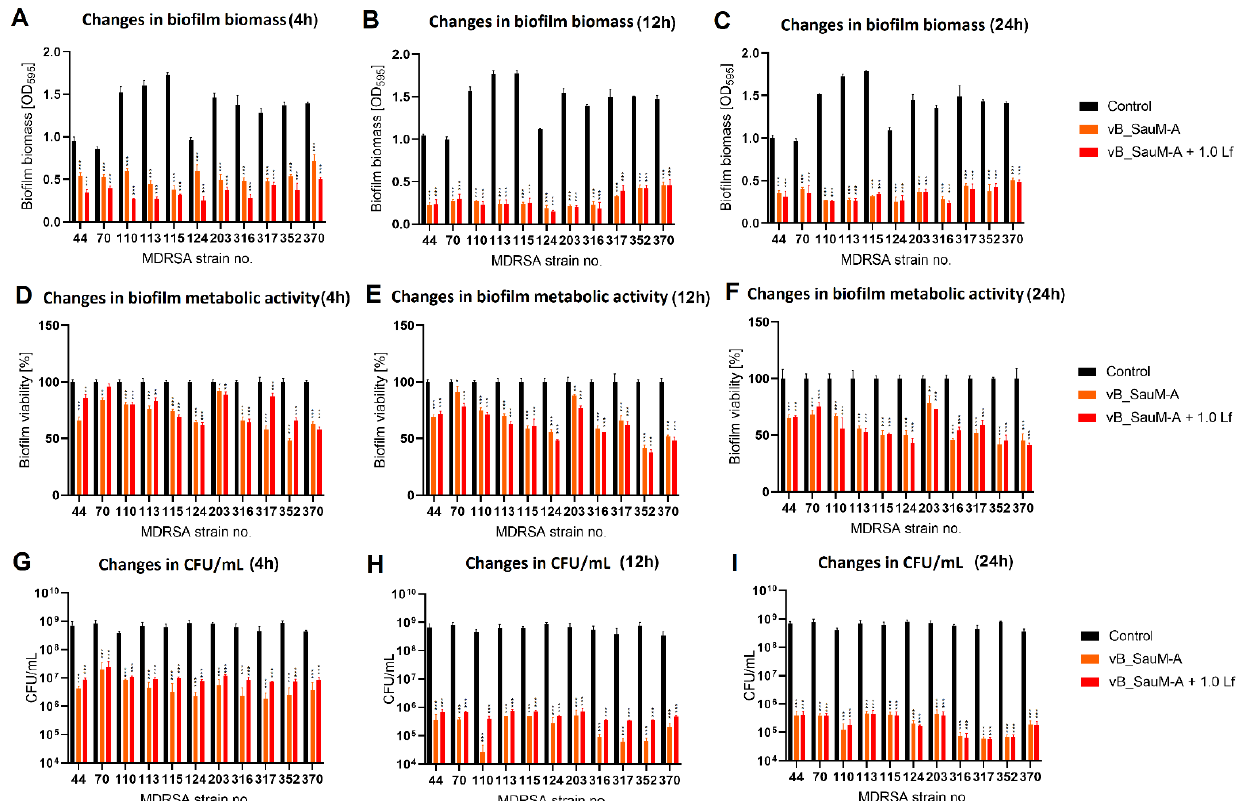
Figure 5. Influence of phage vB_SauM-A and vB_SauM-A+ 1.0 mg/mL lactoferrin (Lf) on MDRSA biofilm: biomass ( A – C ), metabolic activity ( D – F ) and CFU/mL count ( G – I ) after 4 h ( A , D , G ), 12 h ( B , E , H ) and 24 h ( C , F , I ) of incubation. Mean of triplicates, with error bars representing SD. Statistical analysis was performed using t -test, p < 0.05 (*), p < 0.01 (**), p < 0.001 (***).